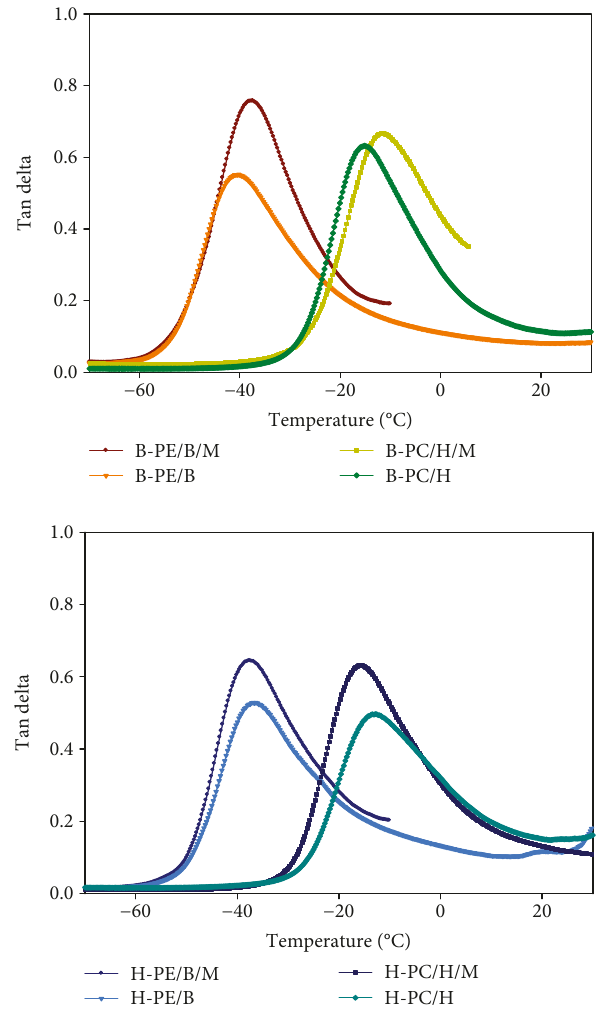
Figure 5: Tan delta of polyurethane fi lms. Table 3: Thermal and mechanical properties of wet-type PU fi